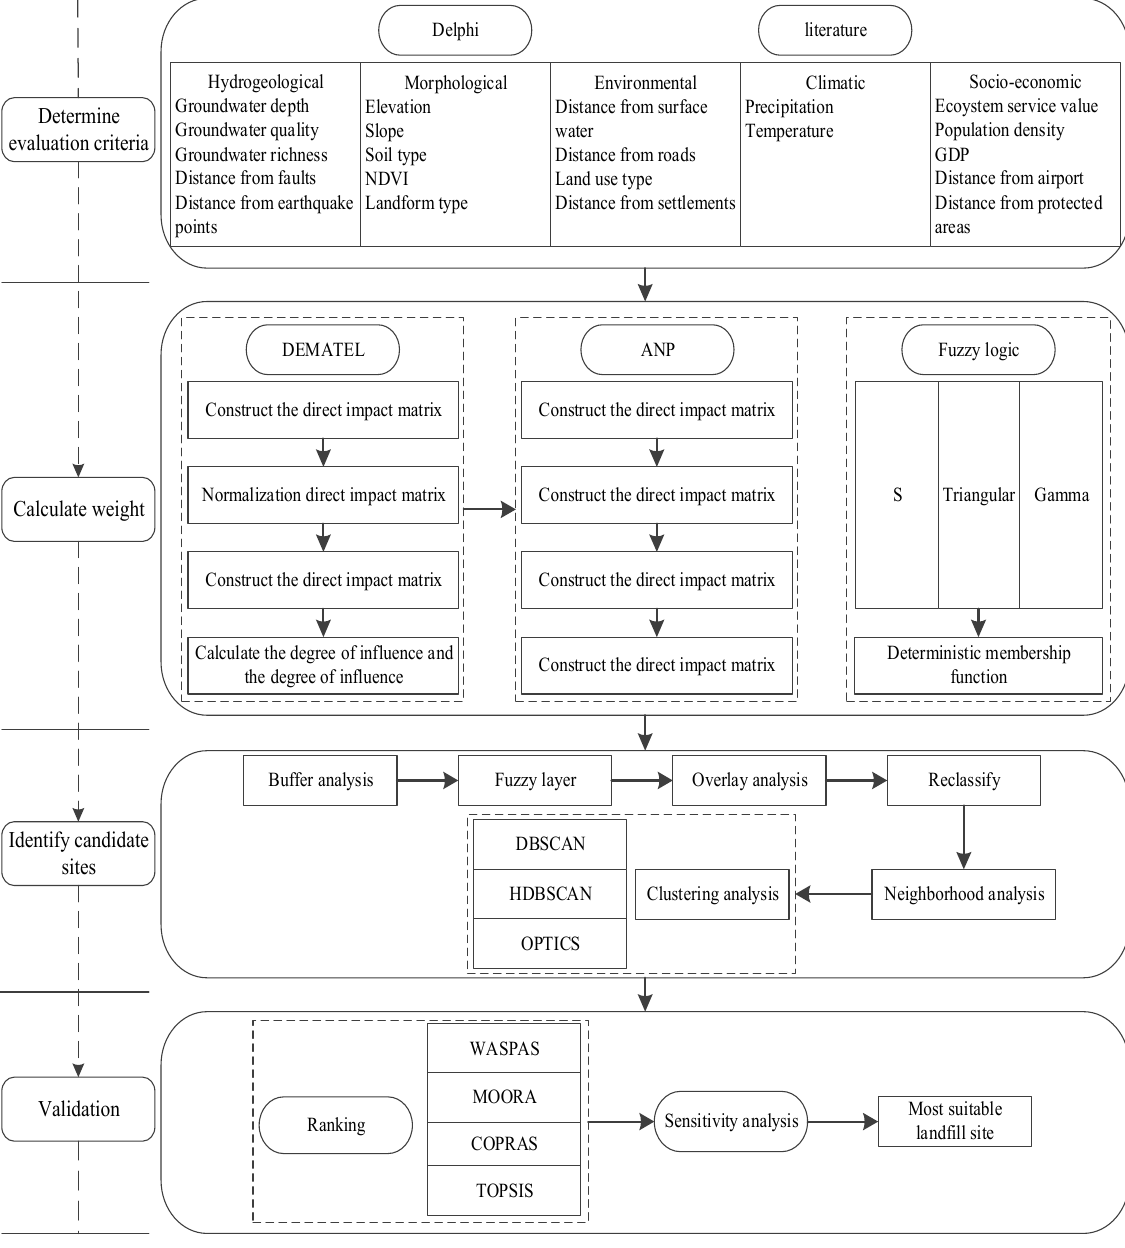
Figure 2. Flowchart of the proposed methodology, including four main steps: determine evaluation criteria, calculate weight, identify candidate sites, and validation.